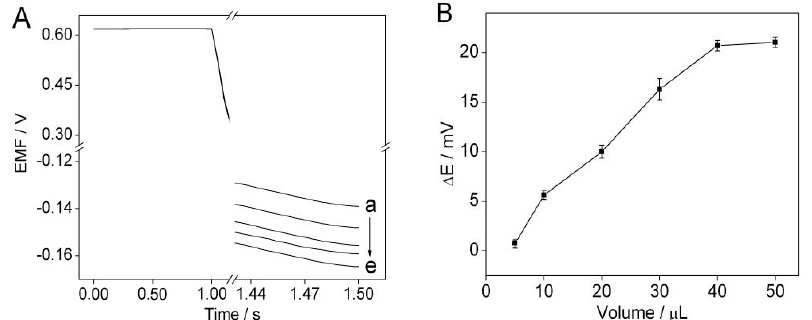
Figure 4. ( A ) Potentiometric responses of the solid-contact polycation-sensitive membrane electrode in 1.5 mL of 0.01 M sodium chloride solution with 5 μ g·mL − 1 protamine in the presence of DNA nanostructure-modified magnetic beads with different volumes of ( a ) 0; ( b ) 5; ( c ) 10; ( d ) 30; and ( e ) 40 μ L. ( B ) Plot shows the potential changes over the volume range of 0–50 μ L for the DNA nanostructure-modified magnetic beads. Error bars represent one standard deviation for three measurements.